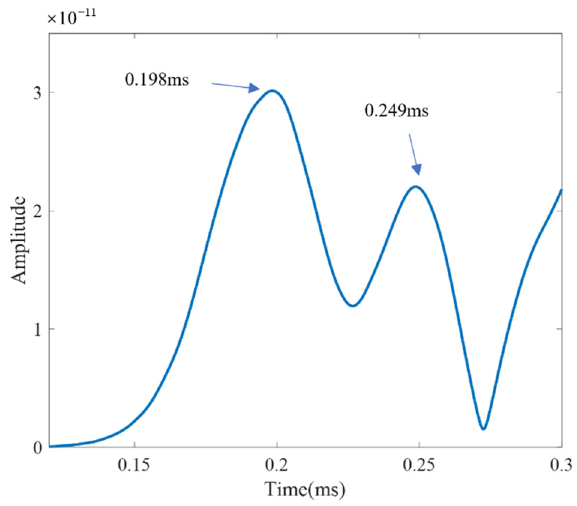
Figure 23. Time ‐ dependent eigenvalue function for two ‐ damage case. Figure 23. Time-dependent eigenvalue function for two-damage